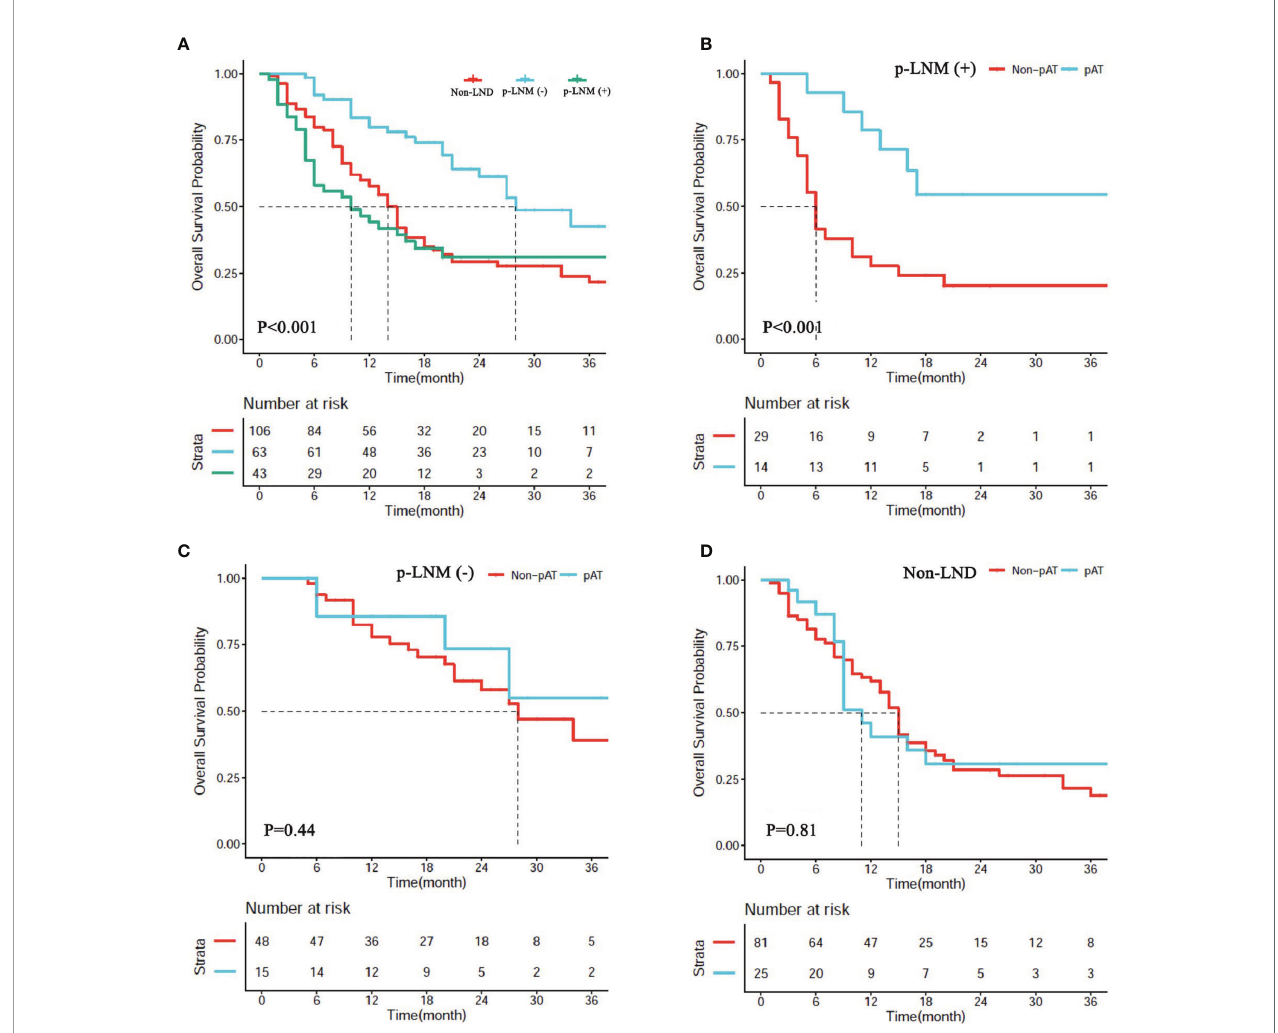
FIGURE 4 | (A) Overall survival (OS) of patients with hepatectomy alone (non-LND), lymph node metastasis (p-LNM+), and no lymph node metastasis (p-LNM − ). (B – D) OS of patients with p-LNM+, p-LNM − , and non-LND receiving postoperative adjuvant treatment or